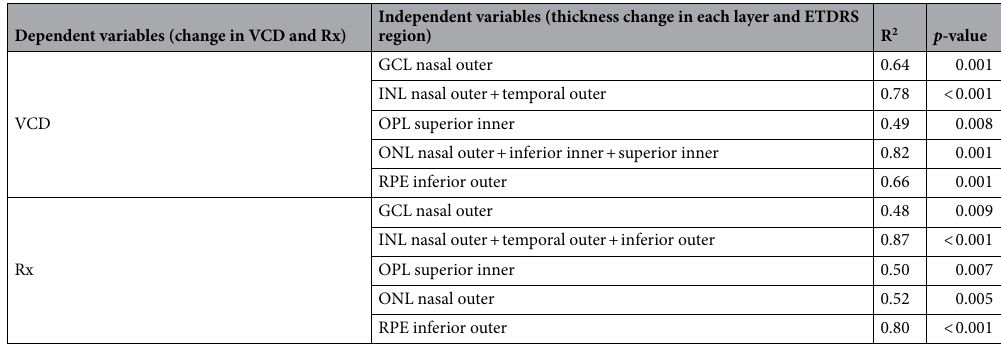
Table 2. Stepwise regression model of the ocular parameters with thicknesses of ETDRS zone in individual retinal layers.